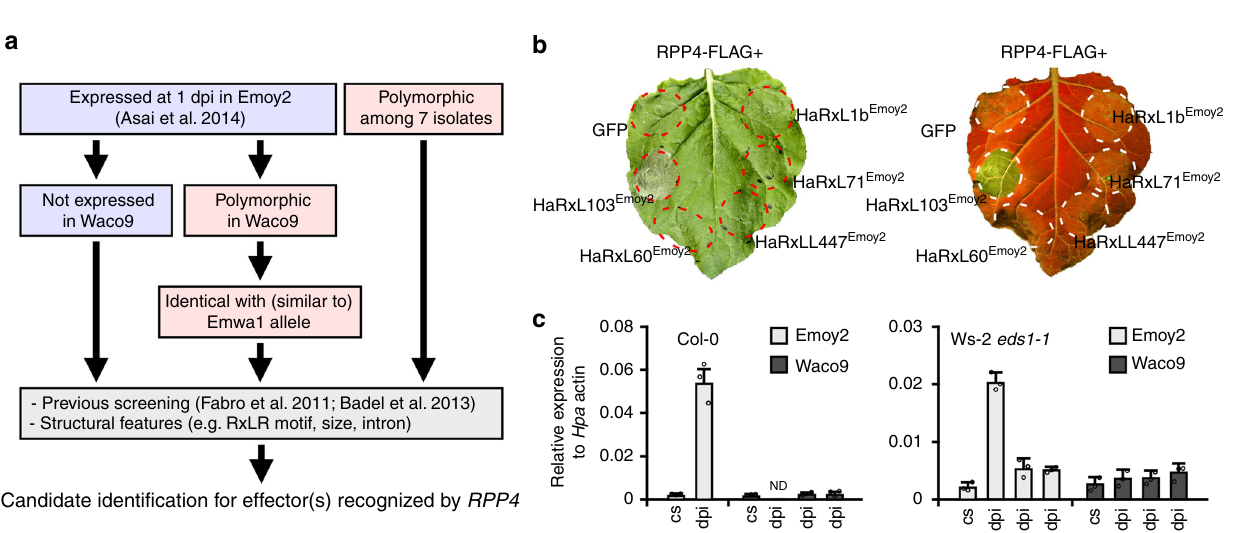
Fig. 1 Identi fi cation of candidate effector(s) recognized by RPP4 . a Flowchart to identify candidate effector(s) recognized by RPP4 . In Hpa effectors expressed at 1 dpi in Hpa Emoy2, not-expressed effectors in Hpa Waco9 during infection and effectors that are polymorphic in Hpa Waco9 and identical